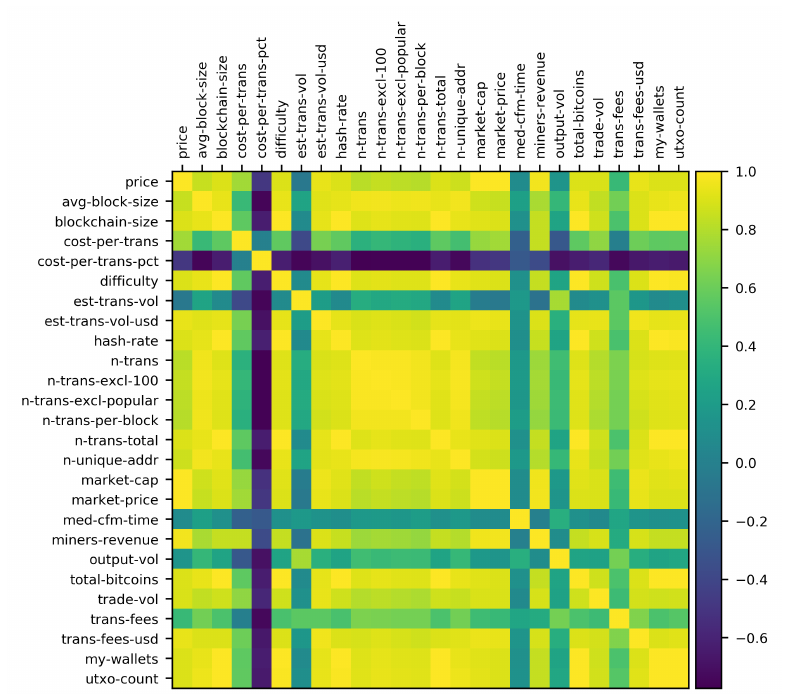
Figure 2. Spearman rank correlation coefficient matrix between Bitcoin blockchain features.